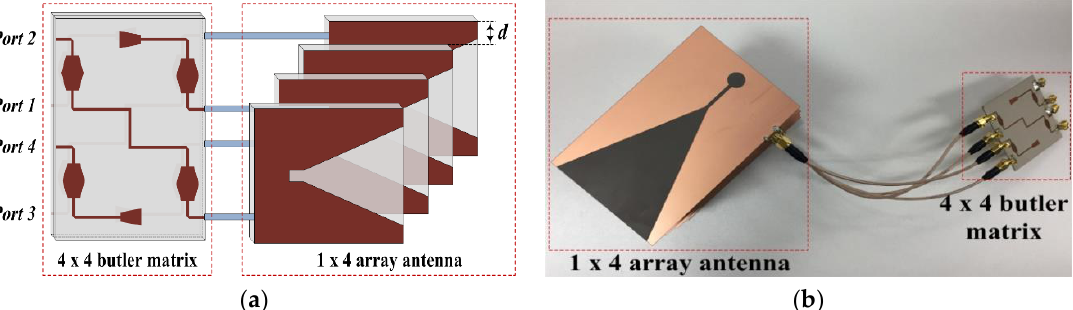
Figure 1. Configuration of the proposed beamforming antenna for indoor wireless positioning: ( a ) geometry and ( b ) photograph of antenna.